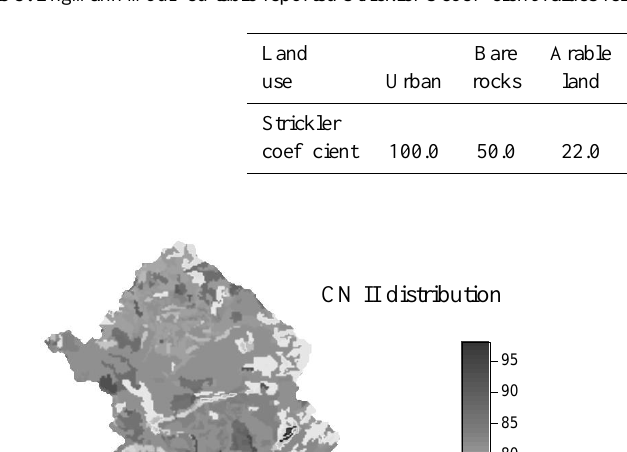
Table 5. Engmann modified table reported Strickler’s coefficient values related to Imera catchment land use.